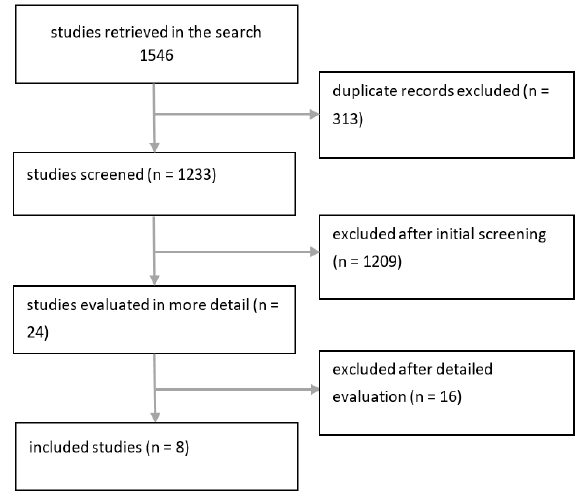
Figure 1. Flow chart summarizing the process of study selection.